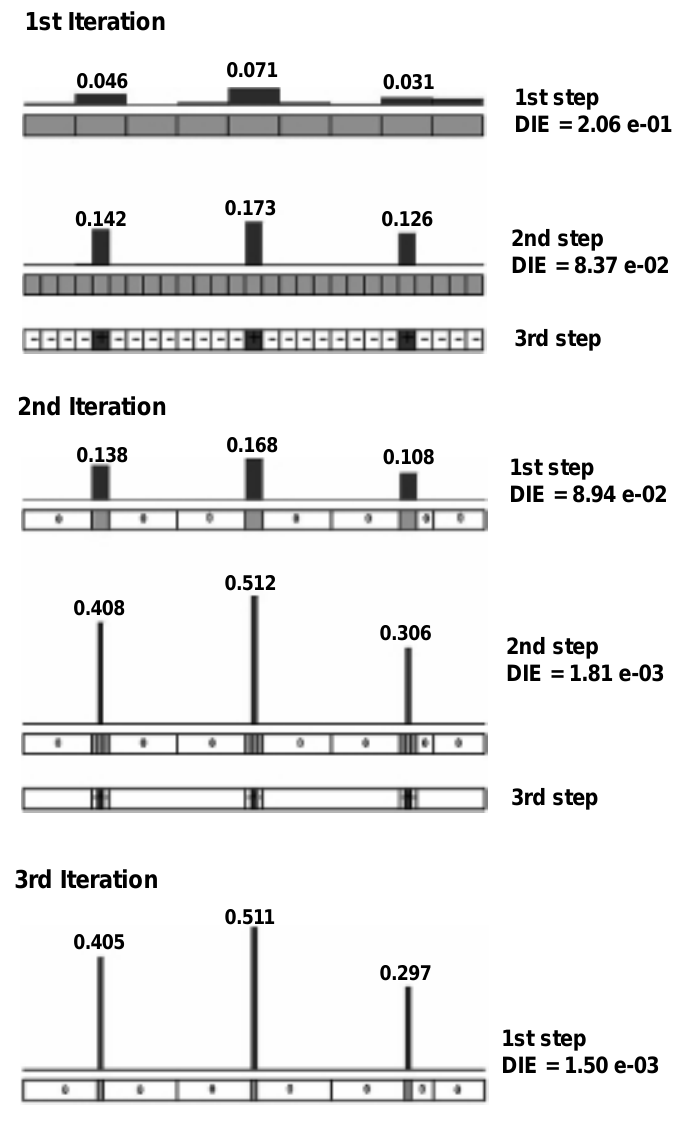
Fig. 4. Detailed procedure of the reduced-domain method: 0% random noise in